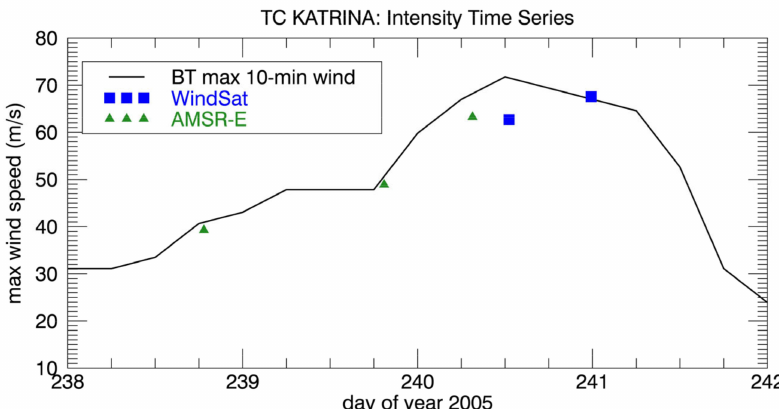
Figure 7. Intensity (maximum wind speed) time series of TC winds from AMSR-E (green triangles) and WindSat (blue squares) passes over Hurricane Katrina in 2005. The black line indicates the intensity time series of the BT data after scaling them to 10-min sustained winds to better match the scales seen by the satellite sensors.